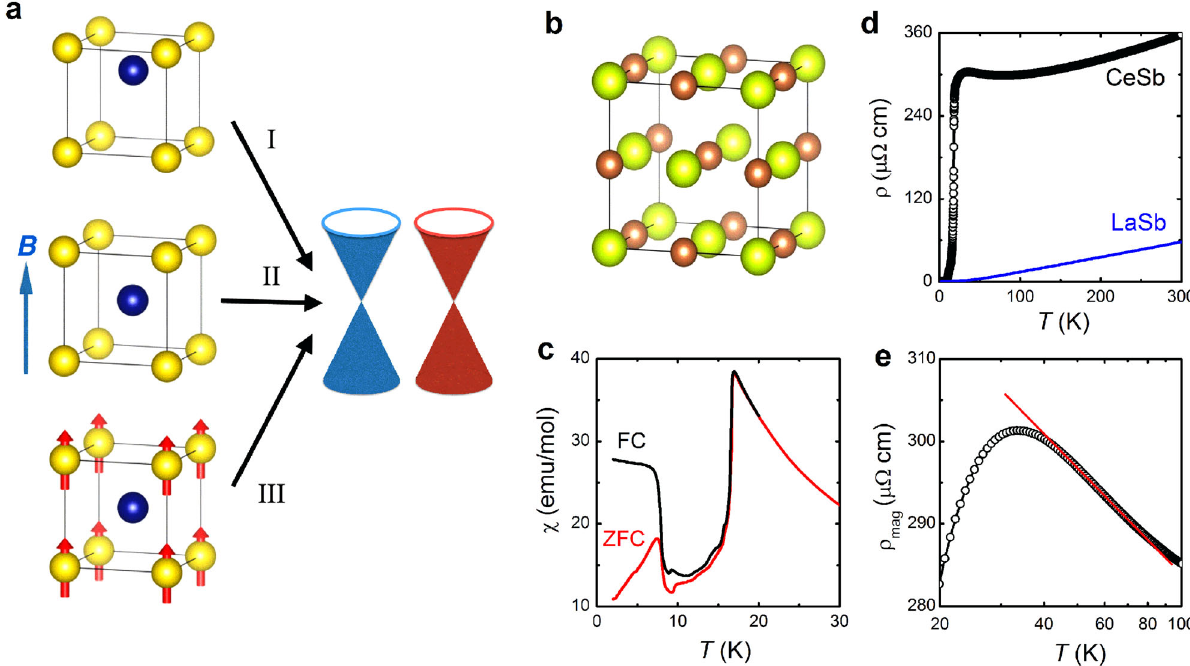
Fig. 1 a Possible routes for achieving Weyl fermions. b – e Crystal structure and characterisation of CeSb. a Schematic diagram for three means of achieving Weyl fermions. Route I is via the breaking of inversion symmetry, route II is via breaking time reversal symmetry by applying a magnetic fi eld, and route III is via breaking time reversal symmetry in the magnetic state. b Crystal structure of CeSb. c Dc magnetic susceptibility of CeSb in an applied fi eld of 0.1 T measured upon warming after zero- fi eld cooling (ZFC) and fi eld cooling (FC) showing a magnetic transition at around 17 K, and another one around 8 K to the antiferro – ferromagnetic (AFF) phase where the ZFC and FC curves split. d Temperature dependence of the electrical resistivity of CeSb and LaSb. e Magnetic contribution to the resistivity of CeSb obtained by subtracting the data for LaSb, plotted on a logarithmic temperature scale. The straight line indicates the logarithmic increase of the resistivity with decreasing temperature below about 80 K, suggesting the presence of Kondo